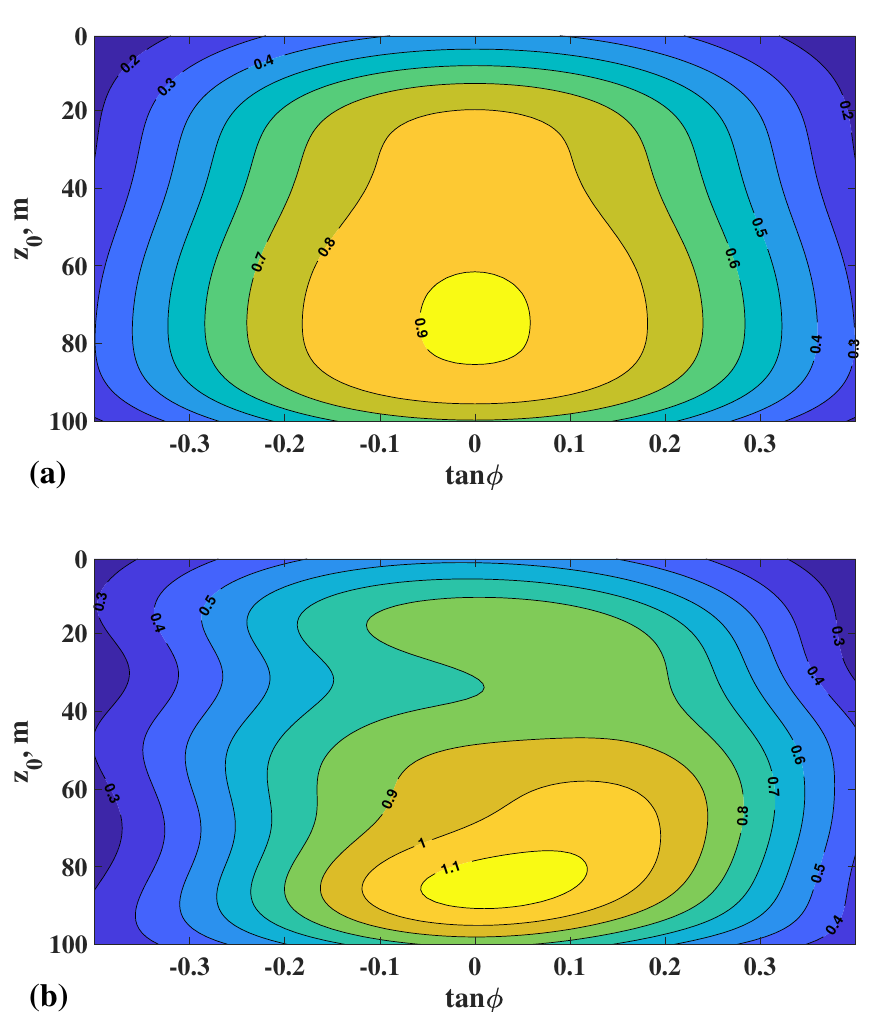
Figure 2. Color diagram depicting dependence of the transmission coefficient on tangent of the launching angle and the initial depth z 0 of a directed Gaussian wave beam. Data are obtained by means of the numerical waveguide scanning relied on the propagator data, the case of the waveguide without pockmarks. The panel ( a ) corresponds to the noiseless propagator data, the panel ( b ) shows √ data averaged over 100 realizations of noise with the amplitude σ =